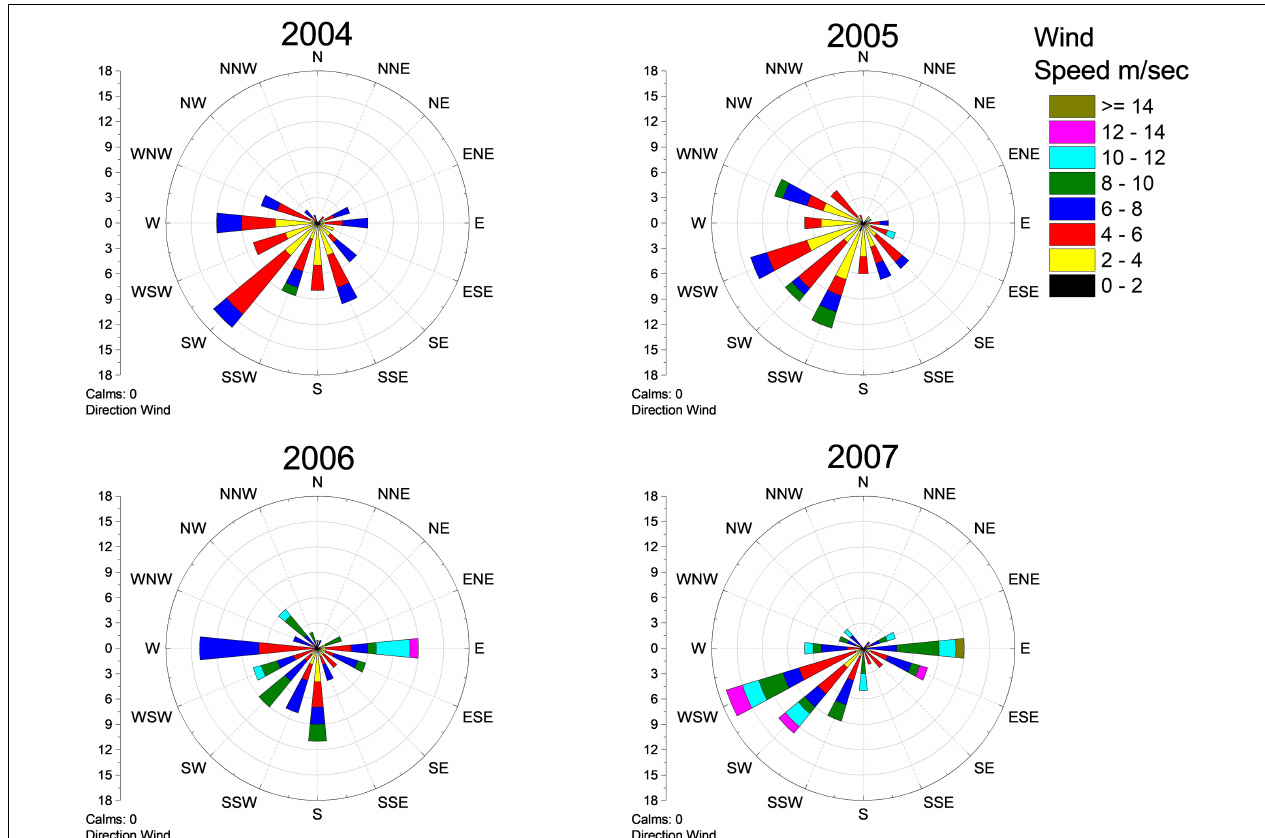
FIGURE 2 | Wind roses from Hanko Russarö weather station (10 km west from the study area) showing wind patterns between June and August during the 4 years,